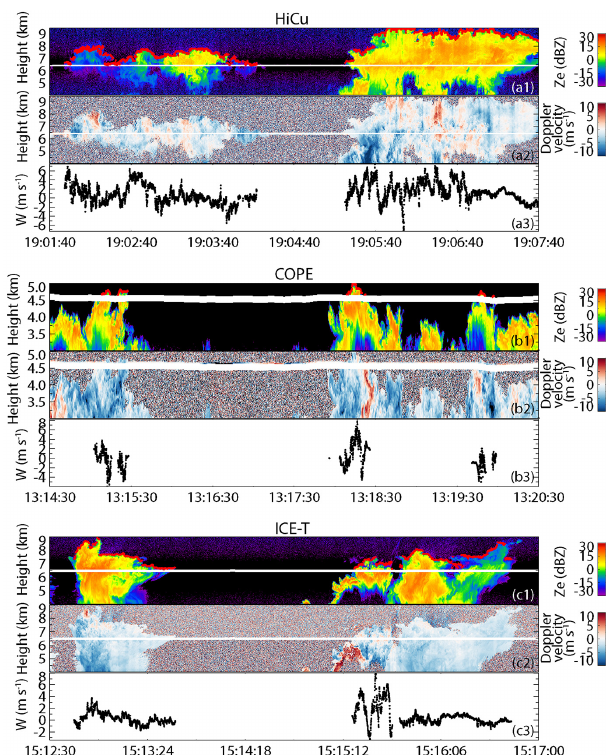
Figure 2. Examples of radar reflectivity, Doppler velocity, and 25Hz in situ vertical velocity measurements for the convective clouds sampled in HiCu, COPE, and ICE-T. The red dots in (a1) , (b1) , and (c1) are the cloud tops estimated by